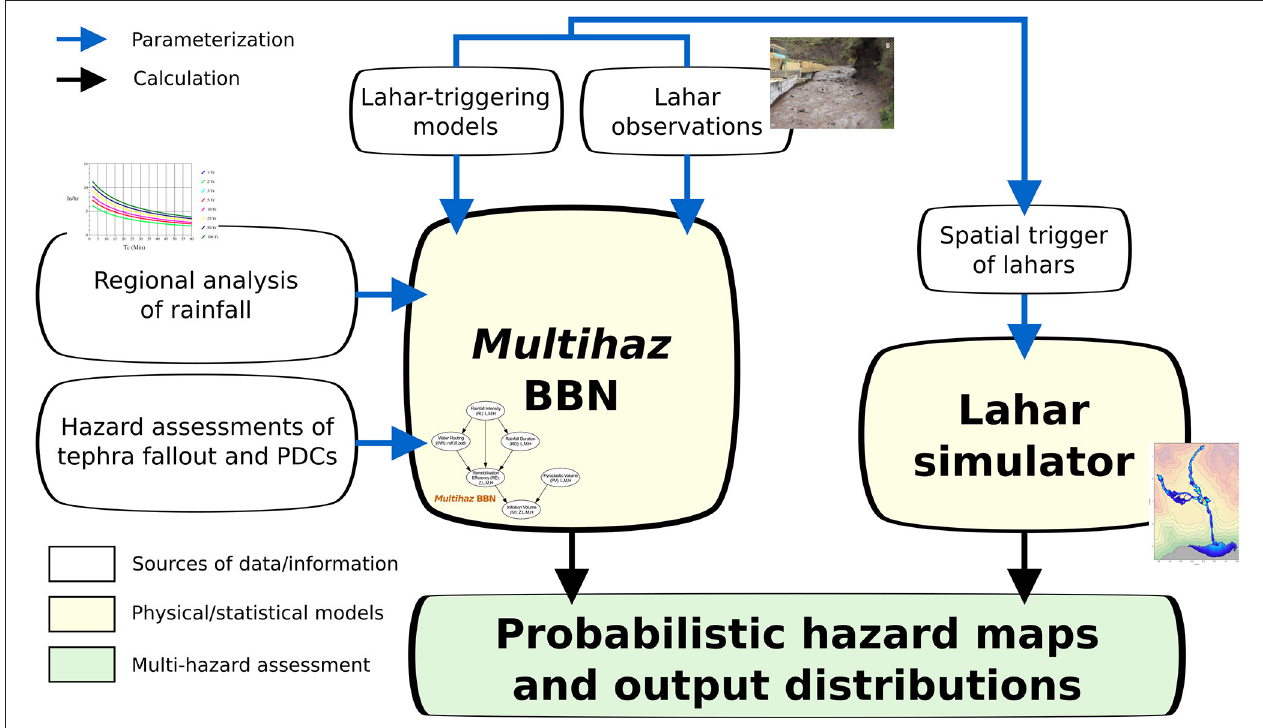
FIGURE 1 | Schematic of our proposed multi-hazard framework in which varied information or data about rainfall characteristics, lahar-triggering mechanisms and availability of fresh tephra is combined quantitatively by a BBN structure ( Multihaz , see Figure 2 ) and also used to set up the initiation points for the simulations of the dynamic lahar model. The Multihaz assessments are then utilized in conjunction with the hazard footprints computed from the lahar simulator to calculate probabilistic hazard maps and discretized output distributions for flow depth and speed of rain-triggered lahars (see text for more details). Graph of regional rainfall and lahar-observation image modified from https://thecriticalflow.wordpress.com and Jones et al. (2015), respectively.